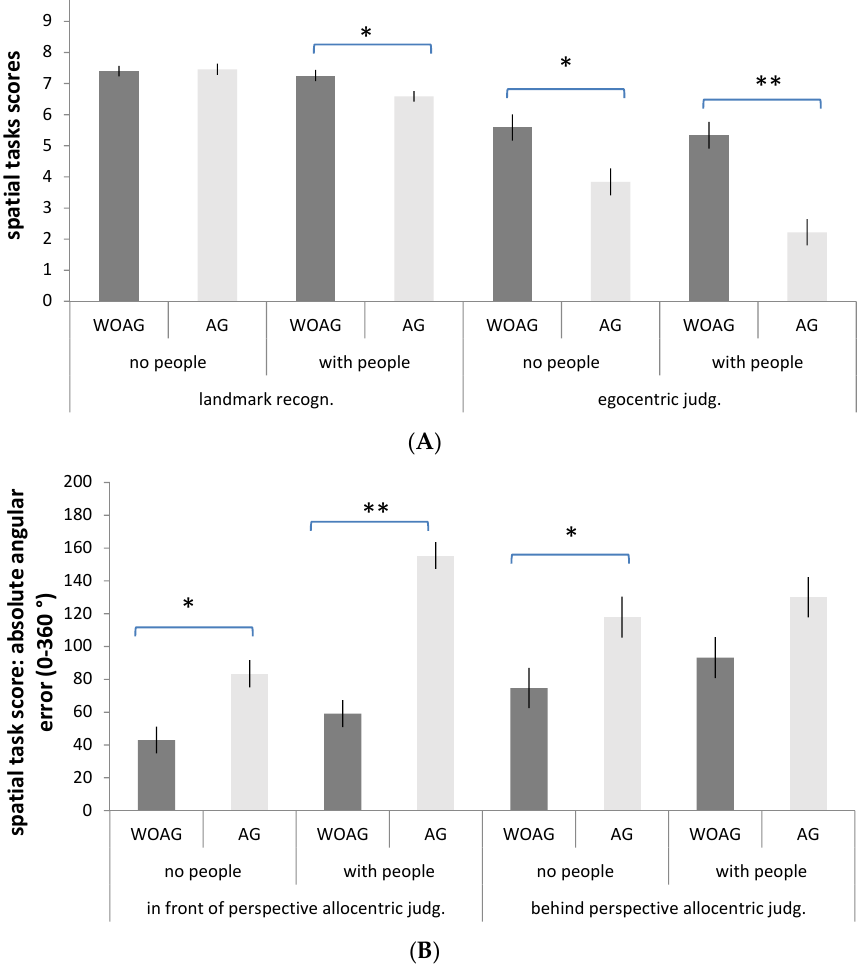
Figure 3. Means and standard deviations for the group x scenario interaction. ( A ) Landmark task and egocentric judgements. ( B ) Allocentric judgements. * p < 0.025 ** p < 0.001